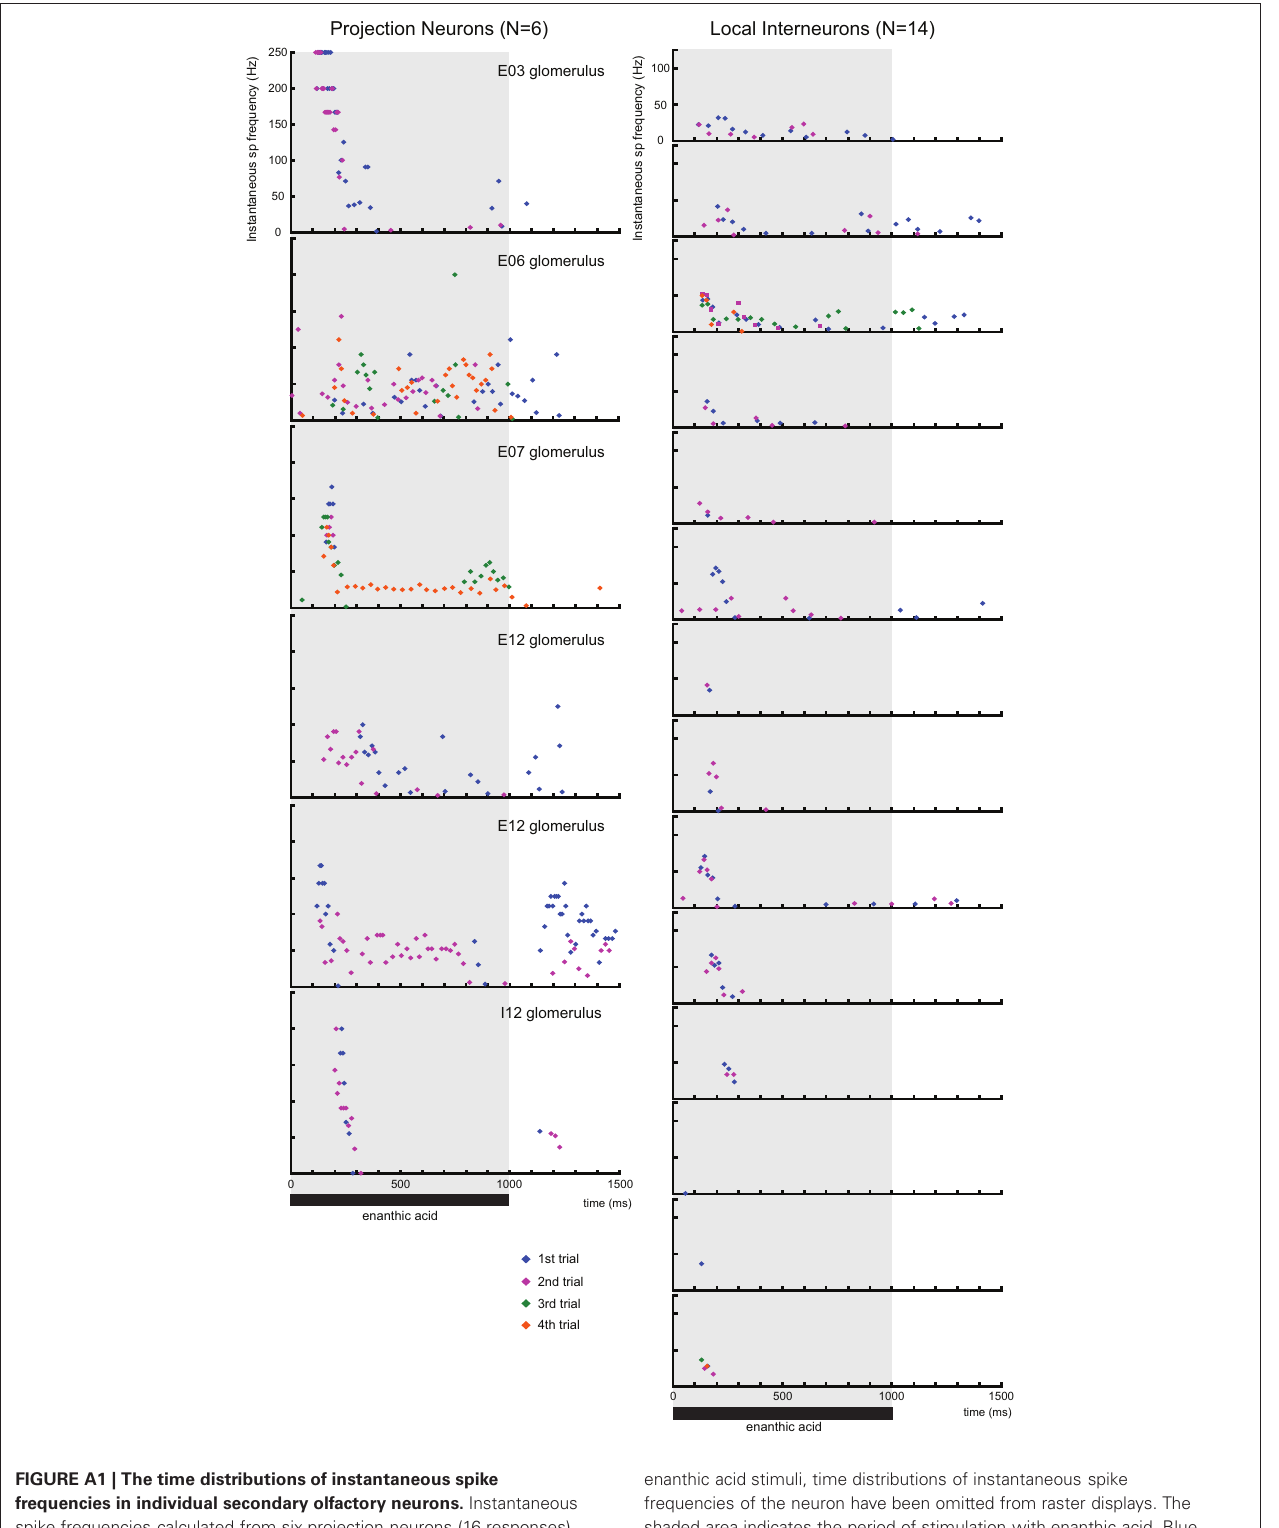
enanthic acid stimuli, time distributions of instantaneous spike frequencies of the neuron have been omitted from raster displays. The shaded area indicates the period of stimulation with enanthic acid. Blue, magenta, green, and orange dots indicate action potentials during first, second, third, and fourth trials,